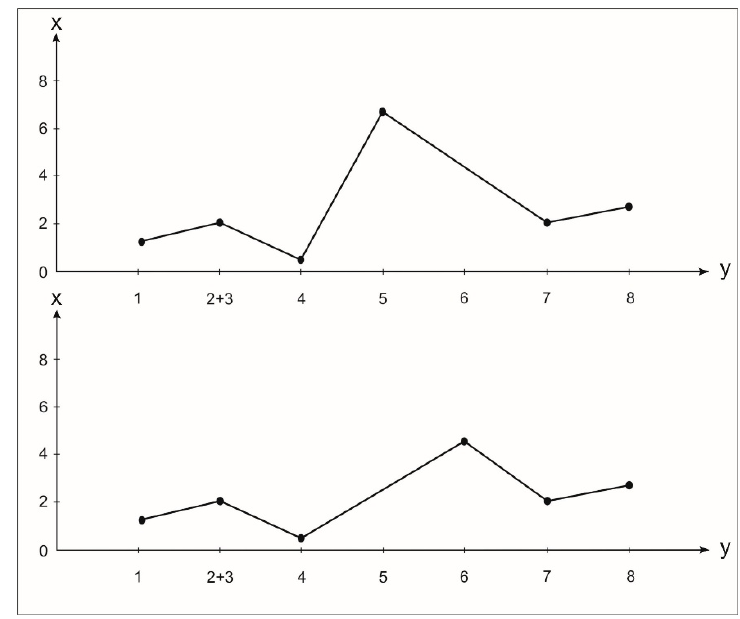
Figure 8. Varying ratios of metavolcanites and metasedimentary rocks distribution (axis x) in the studied complexes (axis y). Groups are numbered as in Figure 3. Constructed in two graphs, for the Murmansk Domain (group 5) and the Belomorian Mobile Belt (group 6).